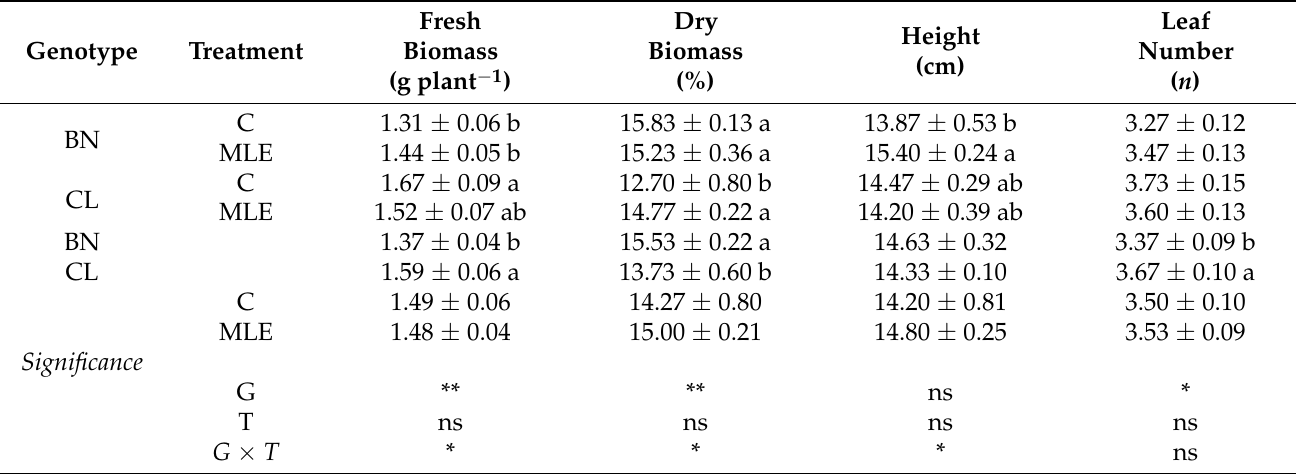
Table 3. Effect of MLE application on fresh (g plant − 1 ) and dry biomass (%), height (cm), and leaf number ( n plant − 1 ) on plant of BN and CL. Extract was sprayed 15, 30, and 43 days after sowing.